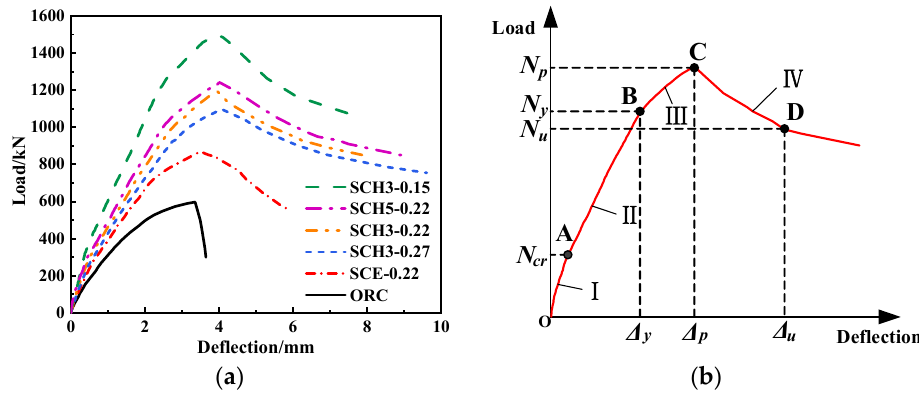
Figure 9. Load-midspan lateral deflection curve. ( a ) Load-midspan lateral deflection curve of test specimens; ( b ) Typical load-midspan lateral deflection curve.